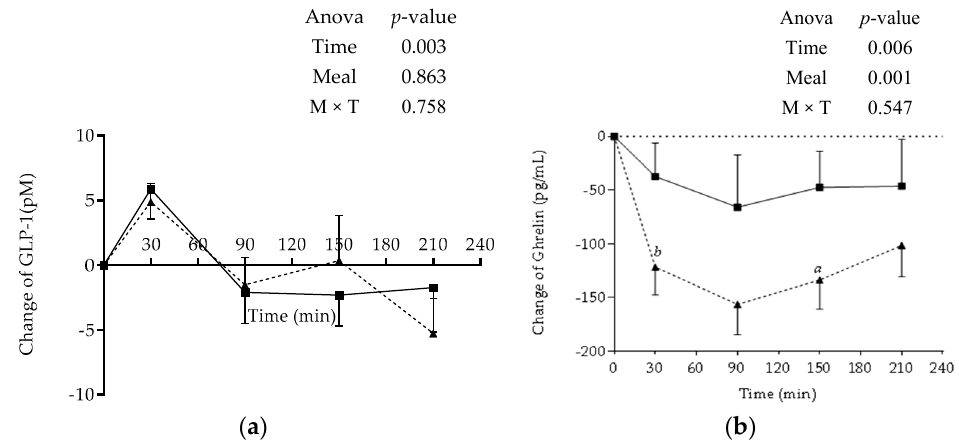
Figure 3. Postprandial changes in plasma glucagon-like peptide 1 (GLP-1) ( a ) and Ghrelin ( b ) from baseline following the ingestion of RM and CM meals. Data are expressed as mean values ± SEM. Values with different letters are significantly different at each time point. a p -value < 0.05, b p -value < 0.01. RM: Regular Mankoushe ------; CM: Chickpeas Mankoushe ―― ; M: Meal; T: Time.